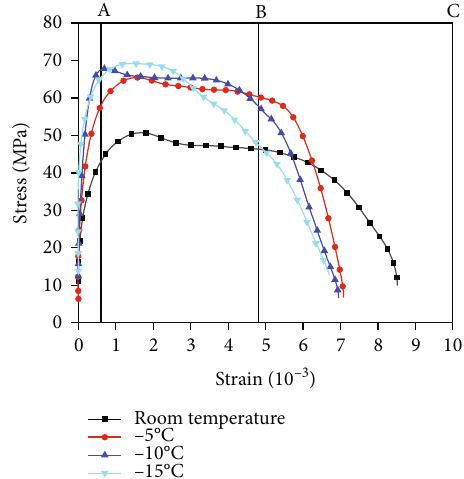
Figure 5: Dynamic stress-strain curve of frozen concrete elements